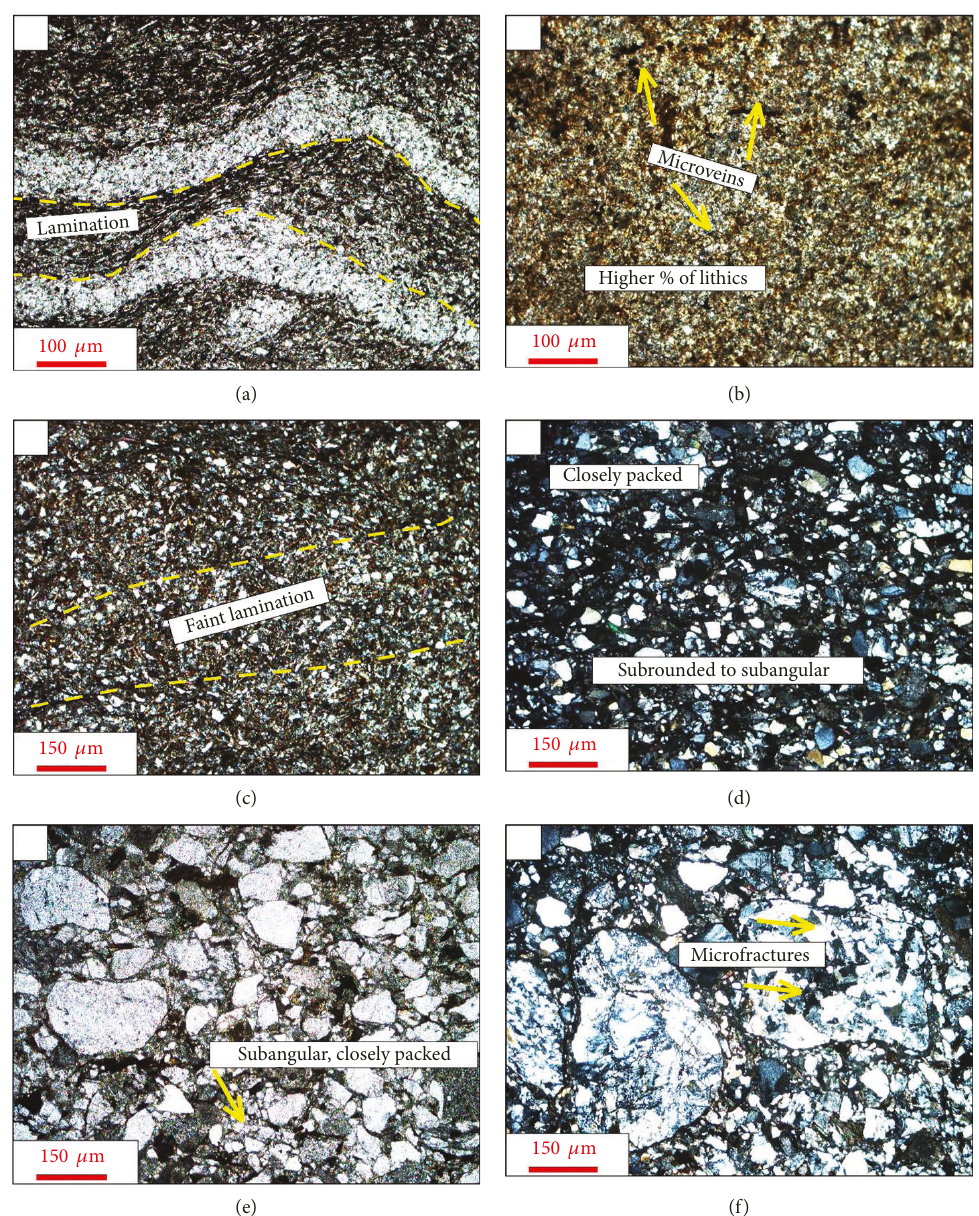
Figure 9: Thin sections of host rock found in the study area examples from: (a) claystone exhibiting plastic fl ow; fi ne sand: (b) siltstone with microfractures present; (c) fi ne sand with subtle layering iso-oriented; (d) medium sandstone; (e) coarse sandstone; (f)